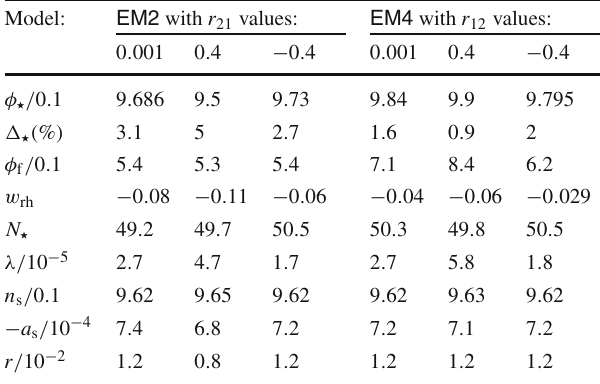
Table 2 Parameters and observables for N = 10, EM2 and M 1 = 0 . 5 or EM4 and M 2 = 0 .